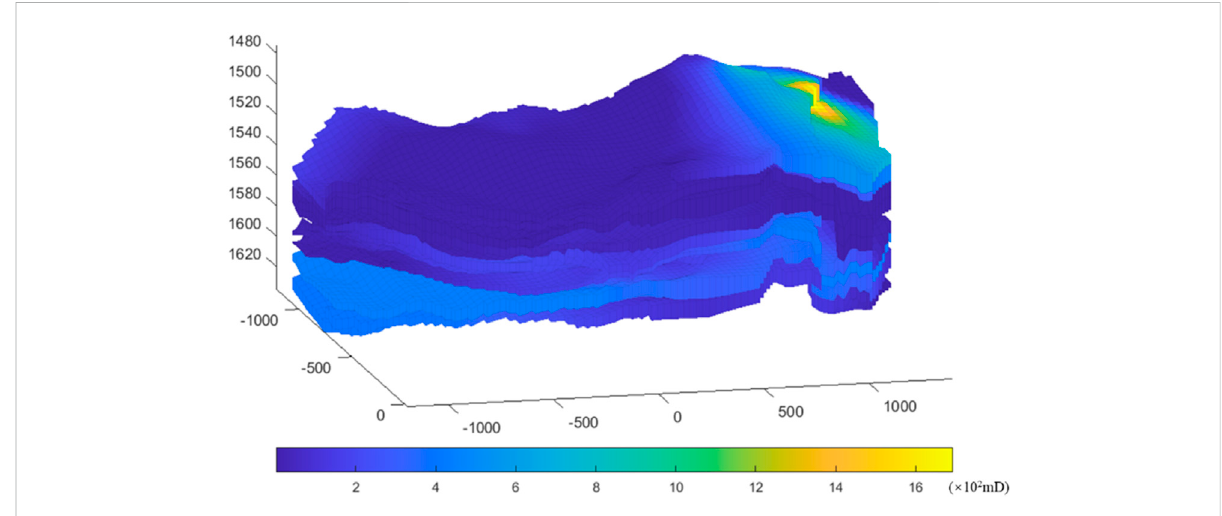
FIGURE 8 Geological structure and permeability fi eld of Bin8-3 unit in Shengli Oil fi eld